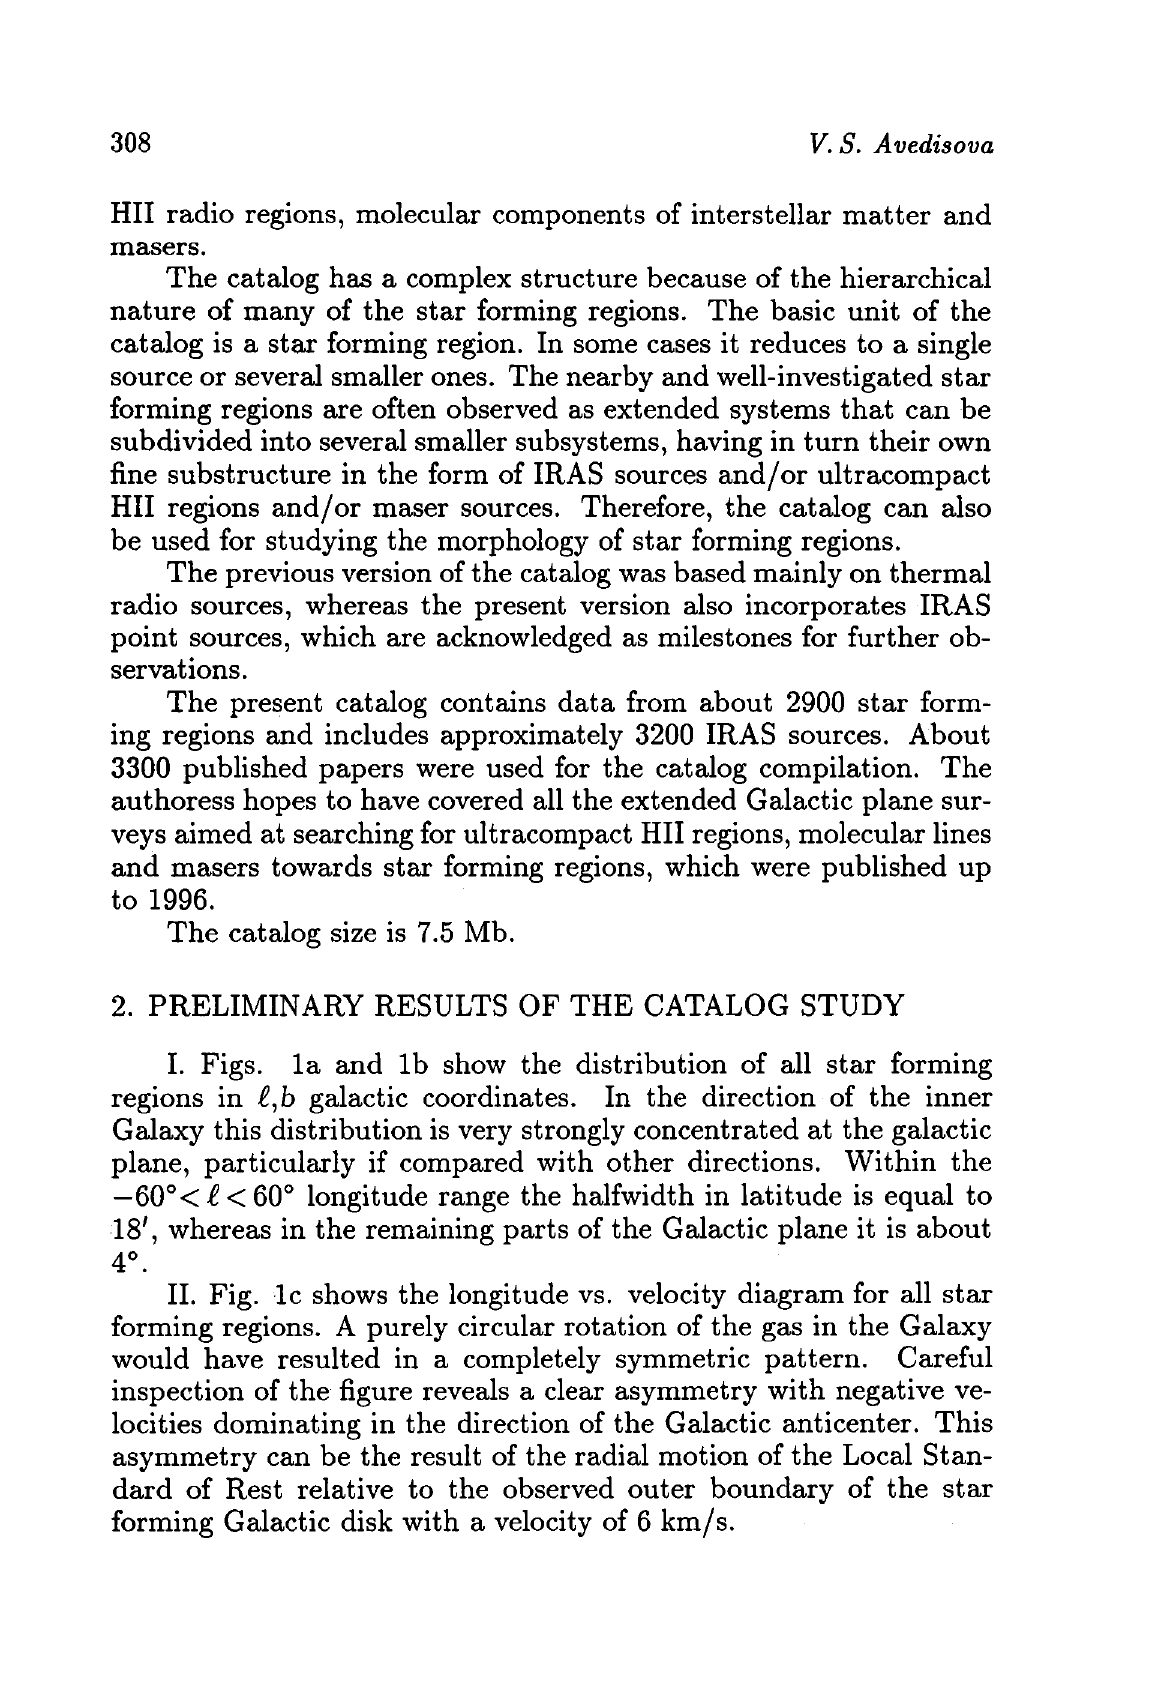
la and lb show the distribution of all star forming regions in £,b galactic